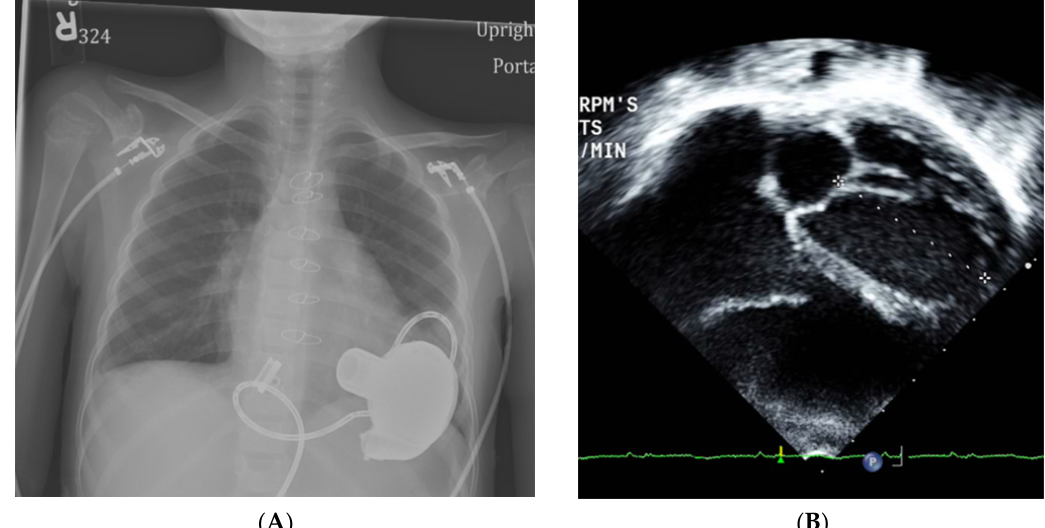
Figure 2. Myocardial recovery after VAD implant. ( A ) Chest-X-ray ~eight months post VAD implant showing resolution of cardiomegaly. ( B ) Post VAD implant, trans-thoracic echocardiogram in the apical four-chamber view showing normal LV dimensions with mildly depressed systolic function, LVEF 51%.